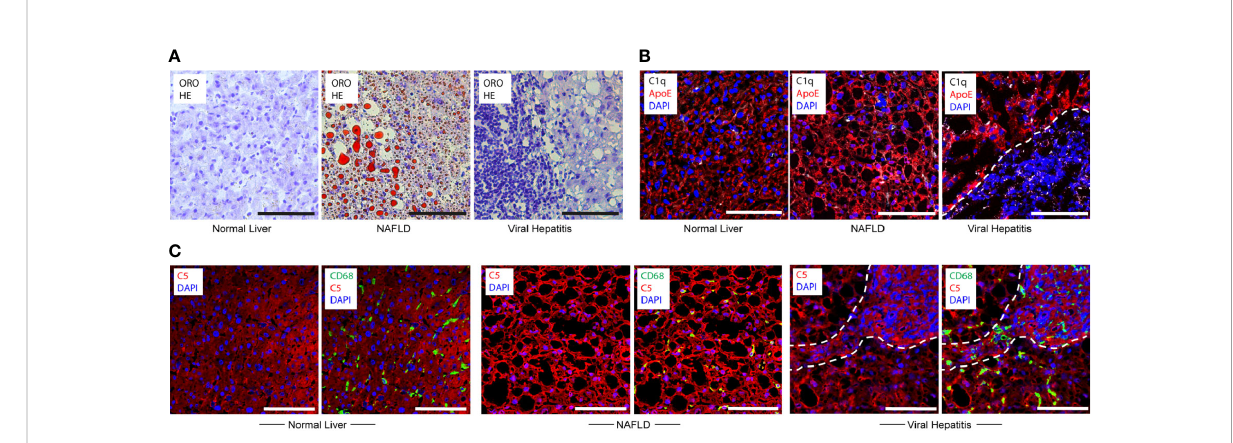
FIGURE 6 Translational studies in healthy and diseased human livers. (A) Normal liver sample Nr. 5 (Supplementary Table 1), NAFLD sample Nr. 9 (Supplementary Table 1) and viral hepatitis sample Nr. 7 (Supplementary Table 1) tissues were stained with ORO for lipid (red) and HE for nuclei (blue). (B) Human livers - as described in Figure 6A - were stained with ApoE (red), C1q (white), and DAPI (blue) showing similar staining patterns vs mouse livers. Dotted lines demarcate immune cell in fi ltration sites from adjacent liver parenchyma. (C) Human livers – as described in Figure 6A - were stained with C5 (red), CD68 (green) and DAPI (blue) indicating nuclei. Representative images of human samples (Supplementary Table 1) are shown. Dotted lines demarcate immune cell in fi ltration sites from adjacent liver parenchyma. Scale bars 100 m